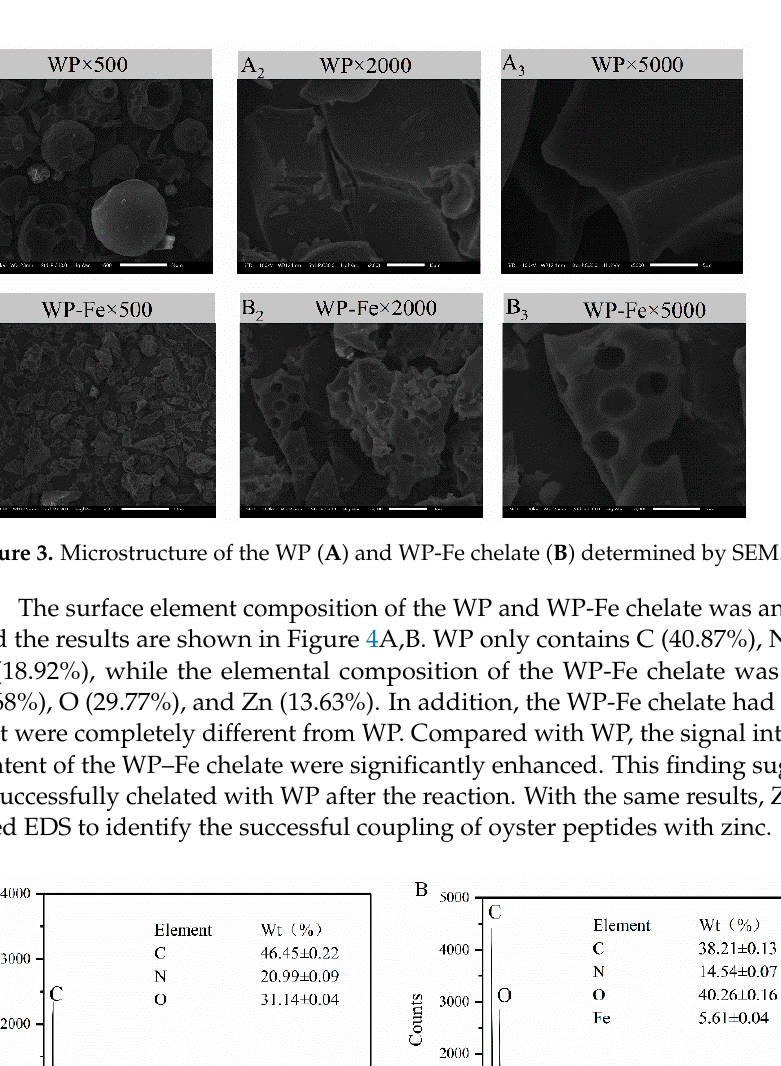
Figure 4. Elemental composition analysis of the WP ( A ) and WP-Fe chelate ( B ).